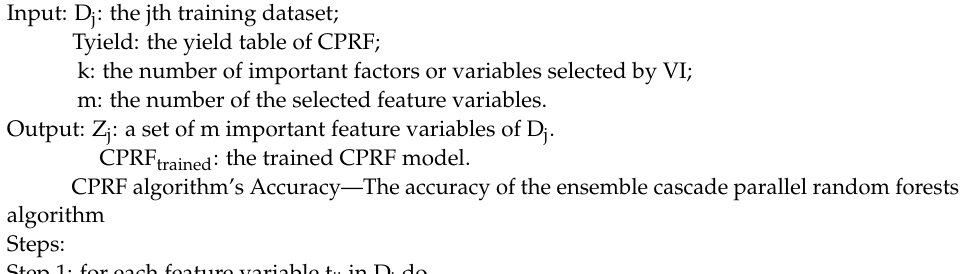
CPRF algorithm’s Accuracy—The accuracy of the ensemble cascade parallel random forests